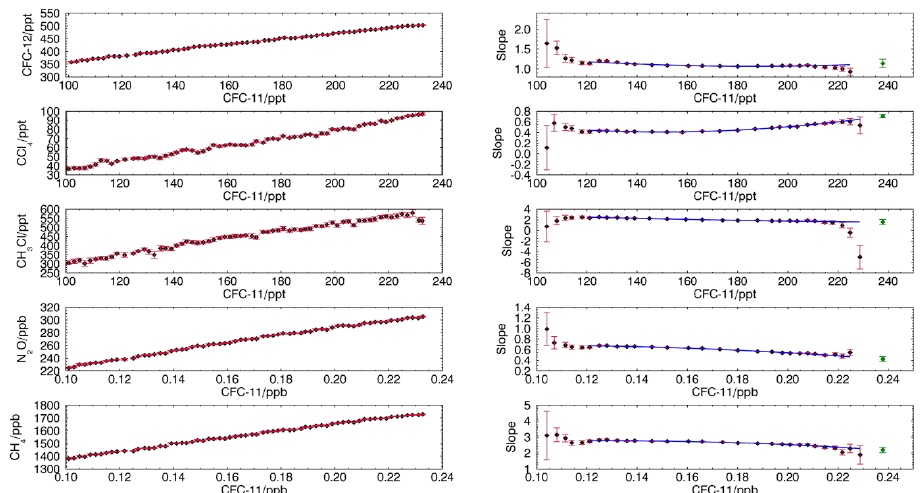
Figure 1: Correlations between the volume mixing ratios of CFC-12, CCl 4 , CH 4 , CH 3 Cl and N 2 O and CFC-11 for the data from the northern hemisphere during the stratospheric winter of 2008. Left panels: the mean correlation curves. Each point represents the mean of the VMR, of both CFC-11 and CFC-12, in a window of 2ppt of CFC-11. The error on these points is the standard deviation of the data within each 2ppt window. Right panels: the local slope of data in an 80ppt of CFC-11 window. The error on the points is the fitting error of this fit. The blue line is a second degree polynomial fit to the local slopes. The green point is the extrapolated slope at the tropopause.